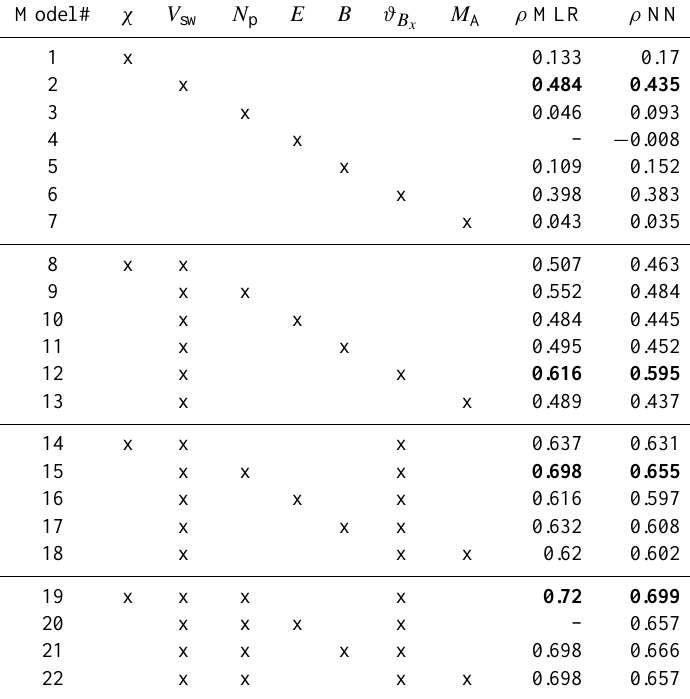
Table 3. Model performance during the wrapper process. Every model (NN and MLR) has a different set of input parameters, marked with x. The correlation ρ between measured and predicted output for the NN- and MLR-based models are listed in the last two columns. The fittest model in each round is number 2, 12, 15 and 19 (highlighted with bold font).